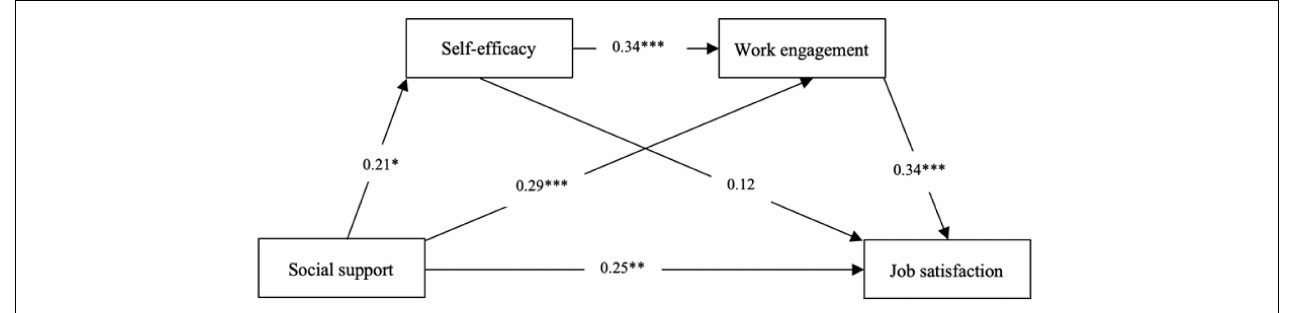
FIGURE 2 | Model result.